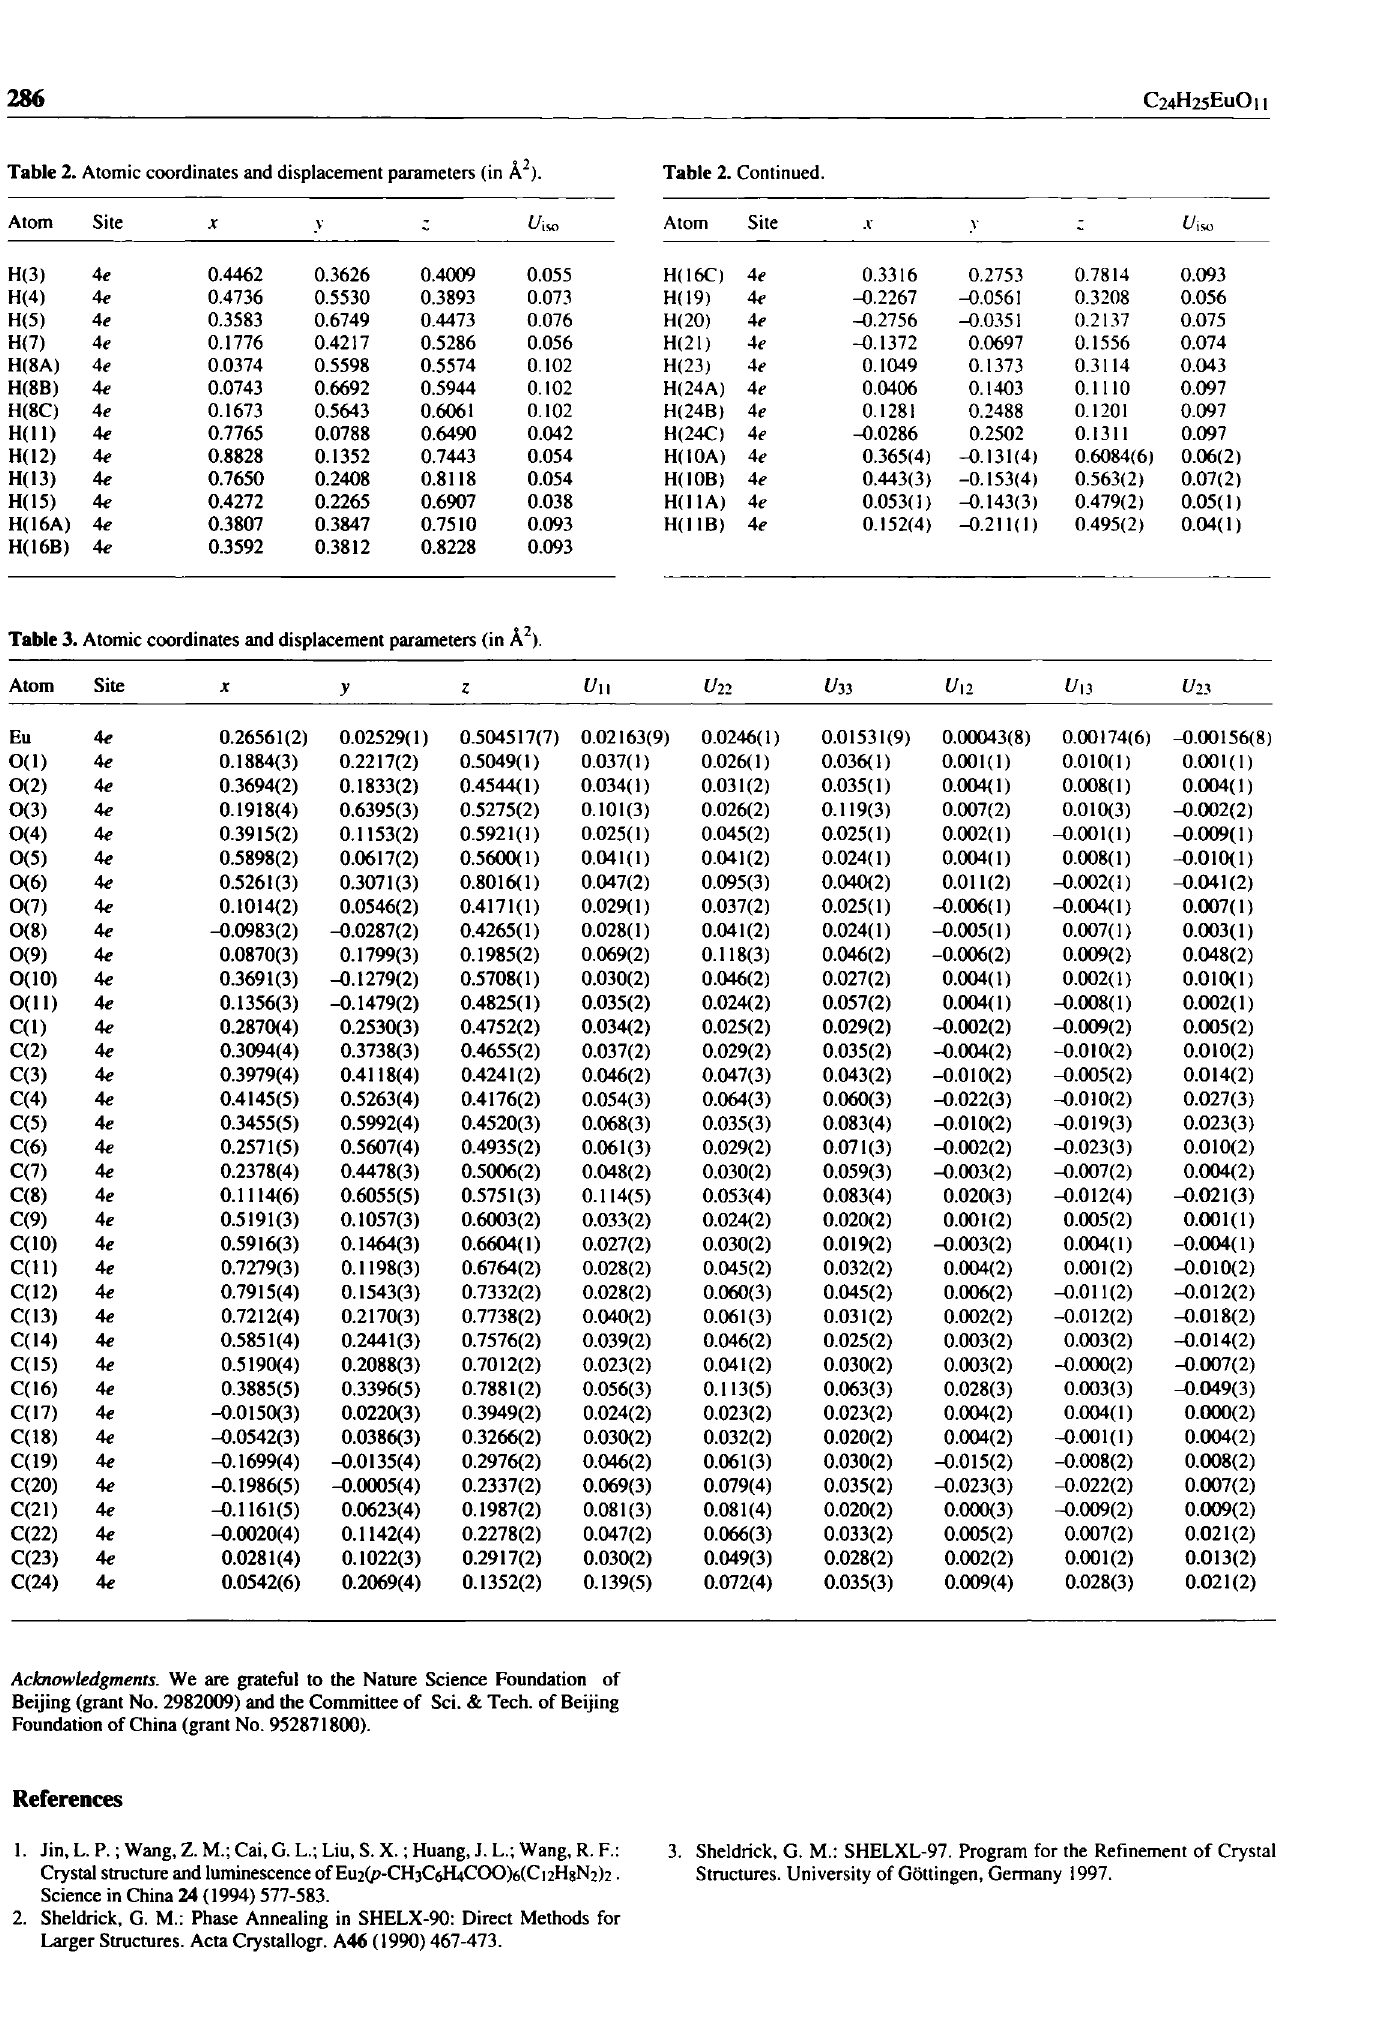
Table 3. Atomic coordinates and displacement parameters (in Ä 2